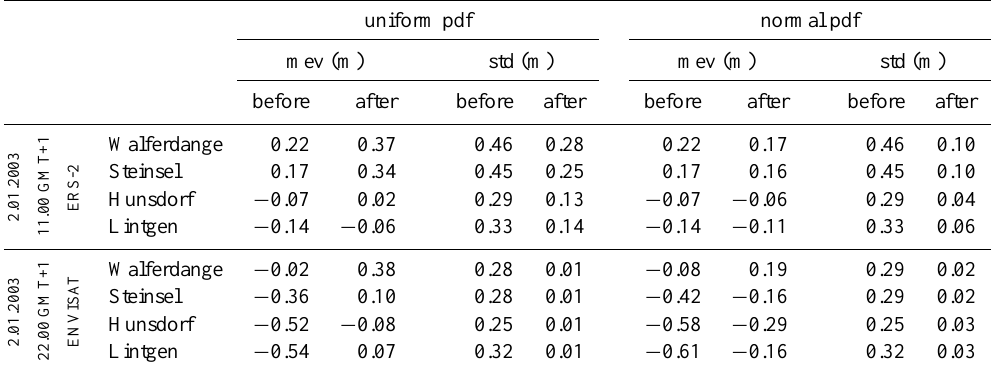
Table 1. Mean error (mev) and standand deviation (std) values computed for the two satellite acquisitions before and after the assimilation analysis step, for the four cross sections with available ground observation measurements, considering the assimilation of the RSD data with the uniform pdf and the use of the normal pdf with the hydrometric station data. uniform pdf normal pdf mev (m) std (m) mev (m) std (m) before after before after before after before